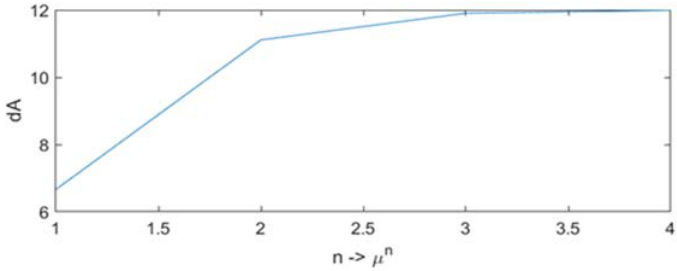
Figure 5. Differences in magnetic potentials between boundaries of the air window versus Fe μ .